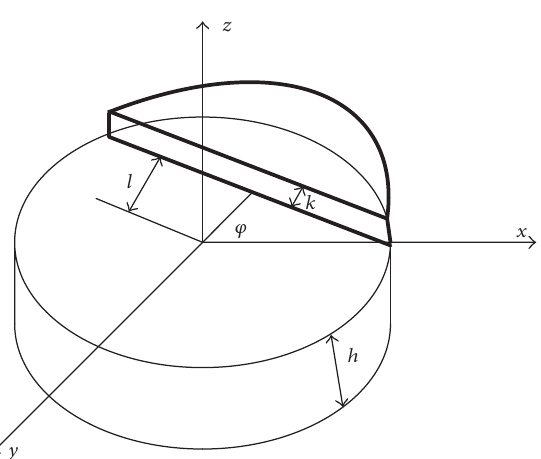
Figure 2: Step model for ideal